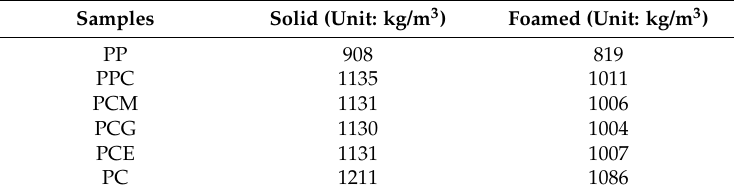
Table 3. Density of the six kinds of PP/PC solid and foamed molded